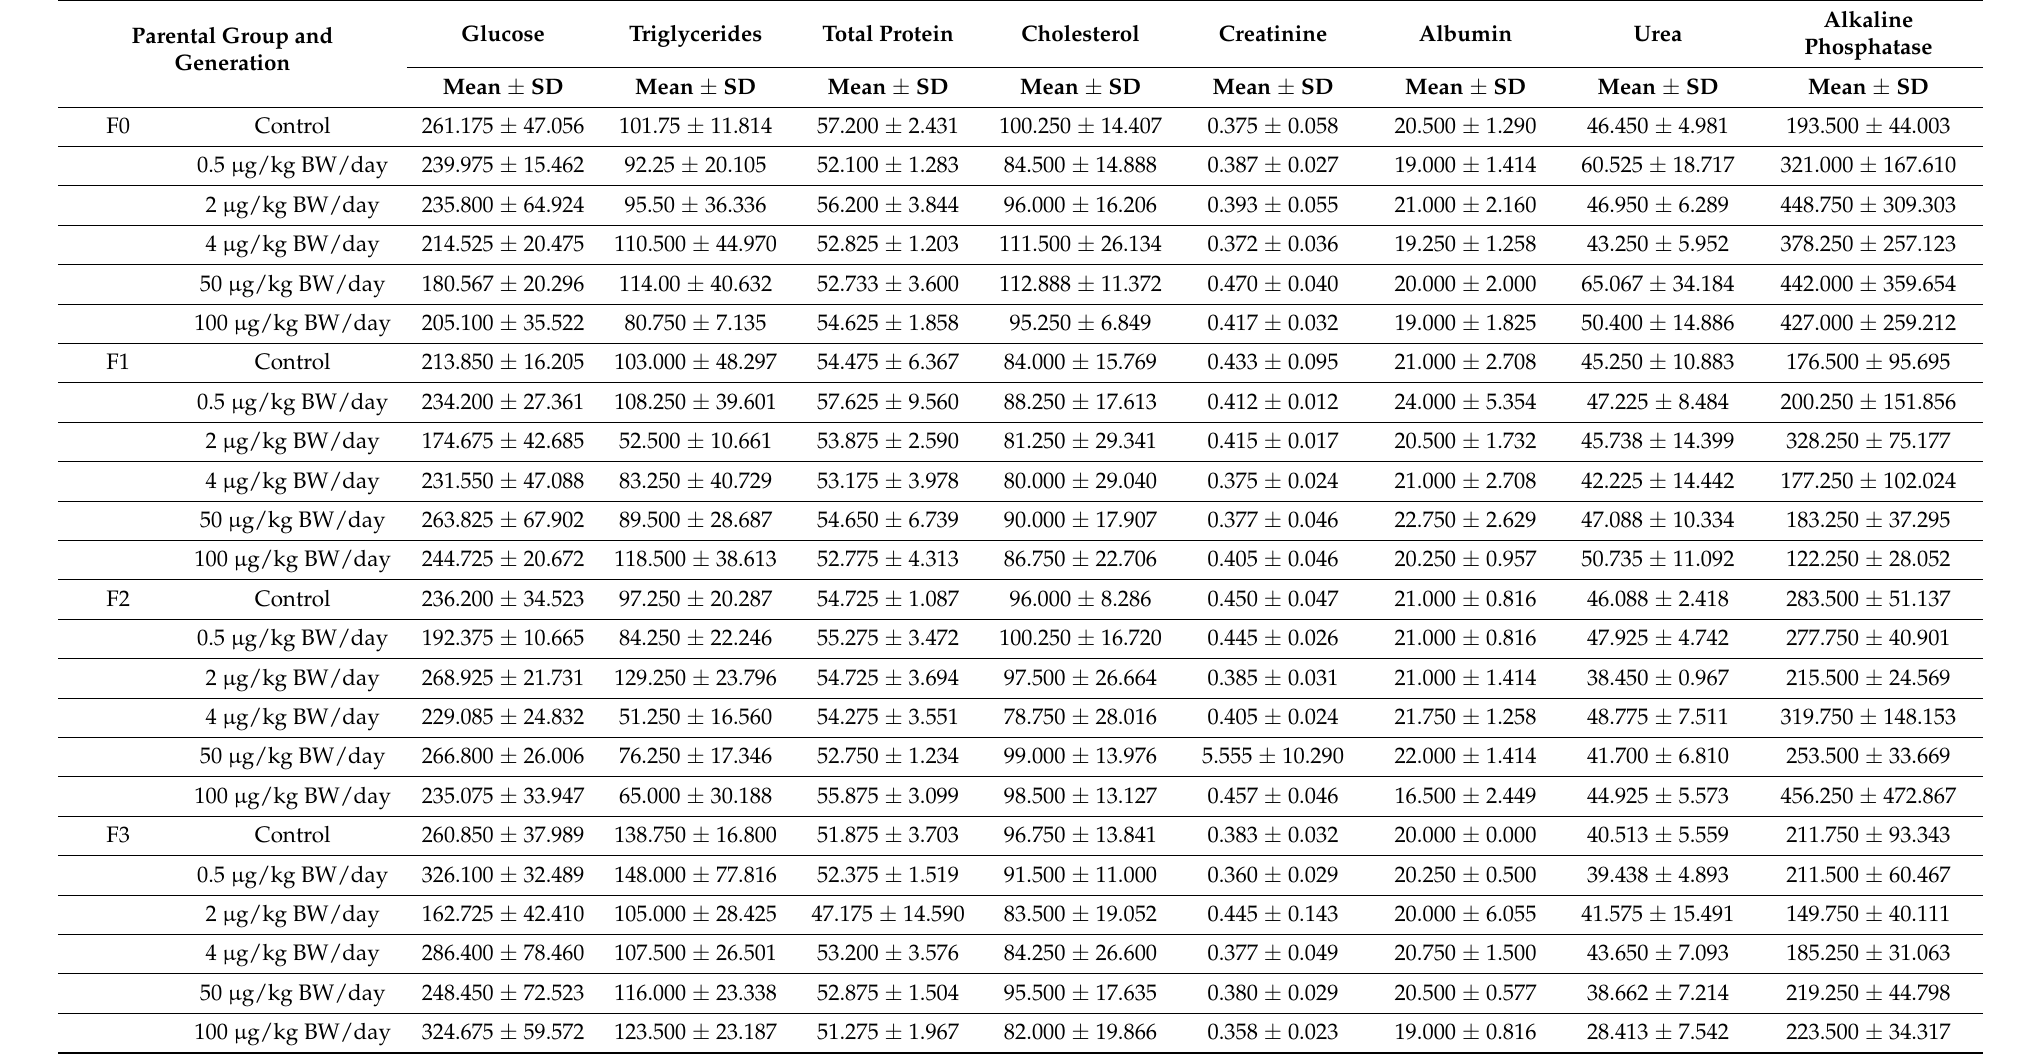
Table 4. Mean values ± standard deviations of the biochemical parameters in the different generations and exposure groups of